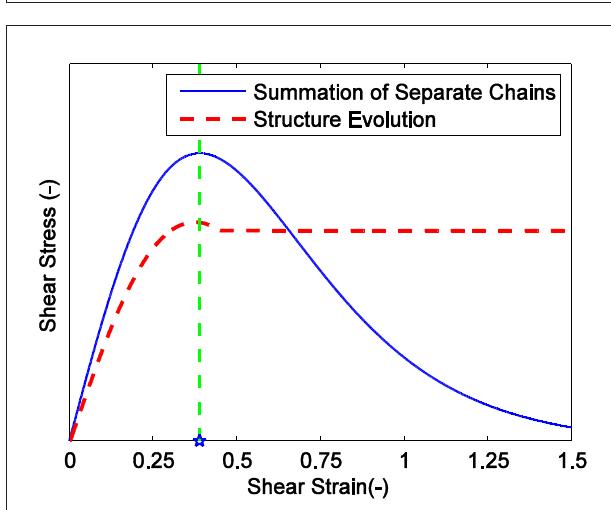
FIGURE 7 | Structural evolution of the multi-chain of MR fluids under magnetic field.